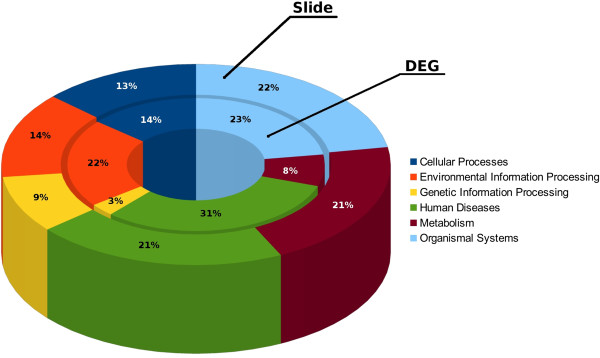
Gene clusters. Comparison of clustering between the 195 over- or under-expressed DEGs (|FC| ≥ 2) and the annotated genes on the slide, was assessed using the NCBI DAVID tool. C1 Class KEGG Pathway was selected as the annotation category for clustering.